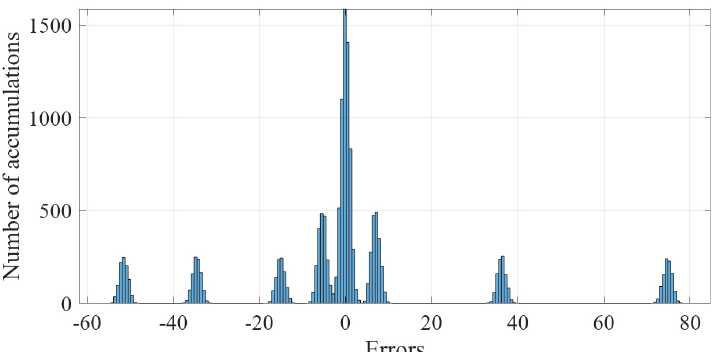
Figure 14. Measurement error of injecting false data.